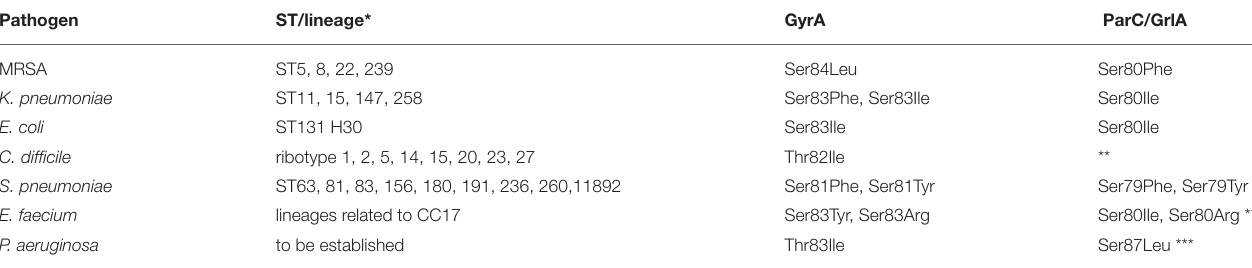
TABLE 1 | Dominant serine/double-serine mutations in “fluoroquinolone-associated” STs/lineages of multi-drug resistant pathogens (see references in